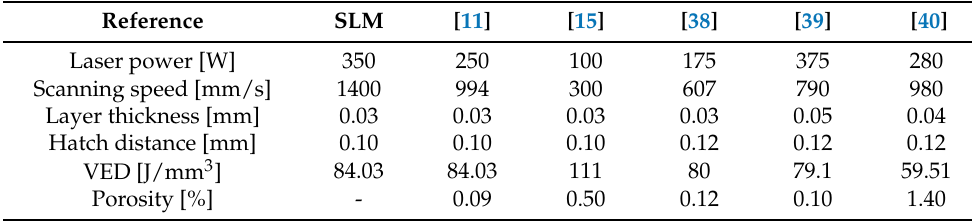
Table 1. SLM process parameters for H13 tool steel powder.